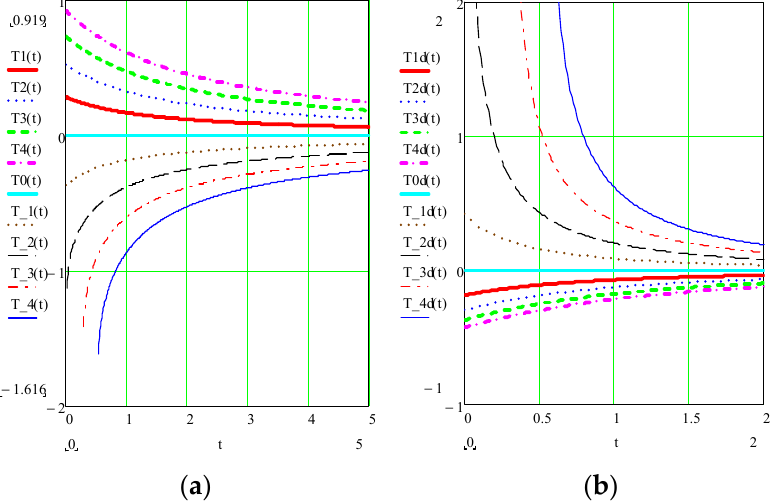
Figure 2. Example of graphs of cross sections of a rhythm function ( a ) and its derivative ( b ) for various fixed 𝑛 .